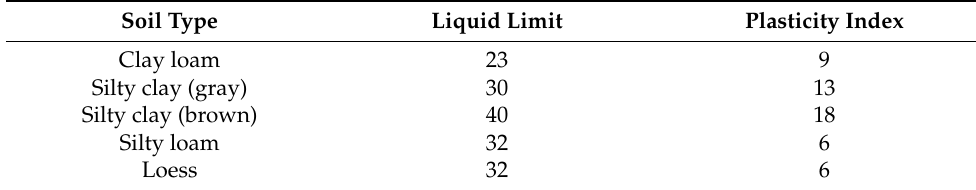
Table 1. Type of soil used for the tests.